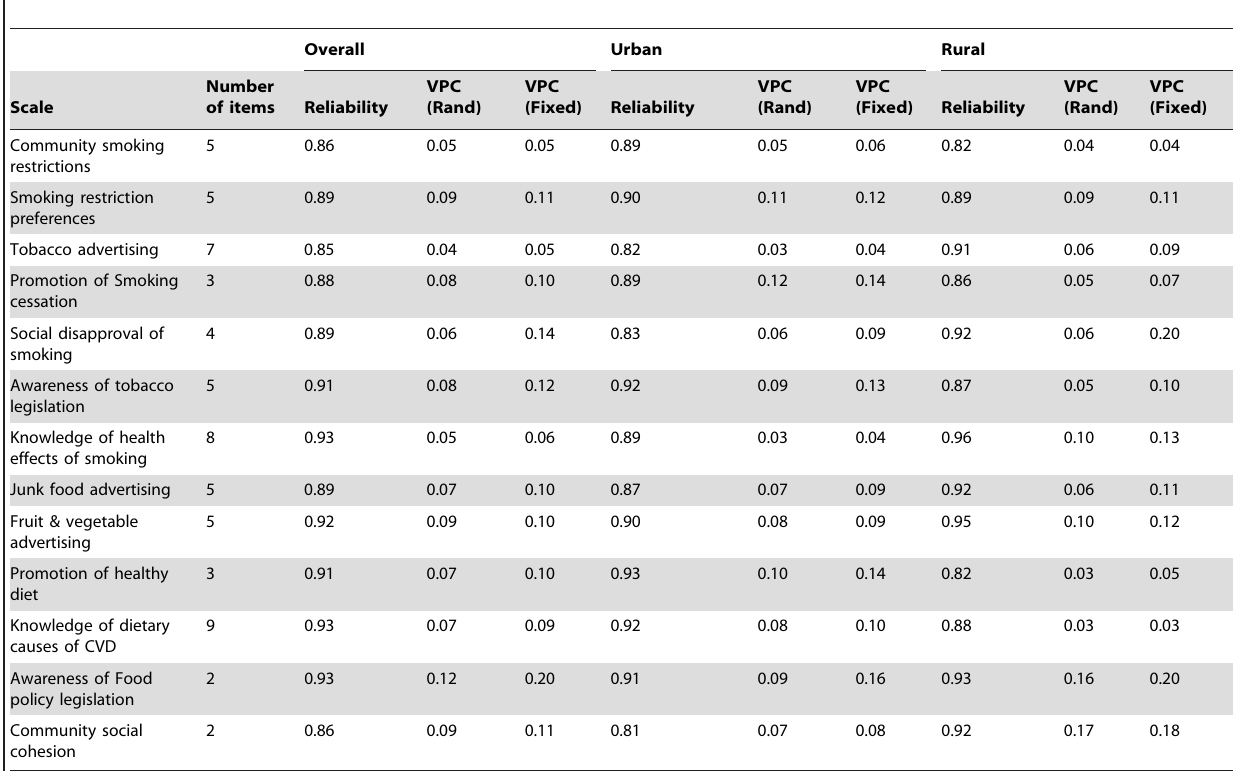
Table 2. Reliability estimates and variance partitioning coefficients (VPC) for thirteen scales measuring characteristics of the community environment potentially related to cardiovascular disease (CVD).